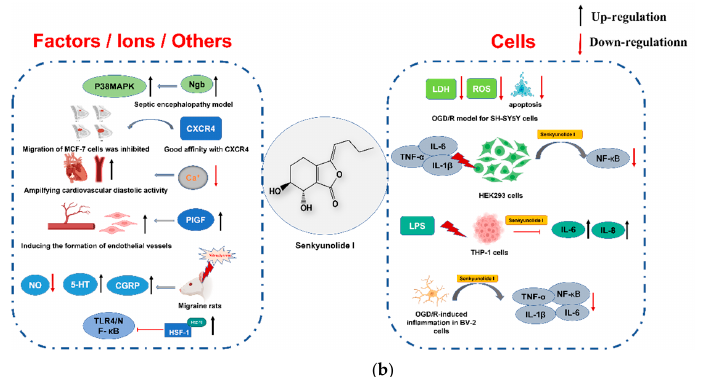
Figure 4. Major pharmacological e ff ects. ( a ) Pharmacological e ff ect on organs; ( b ) Pharmacological e ff ect on